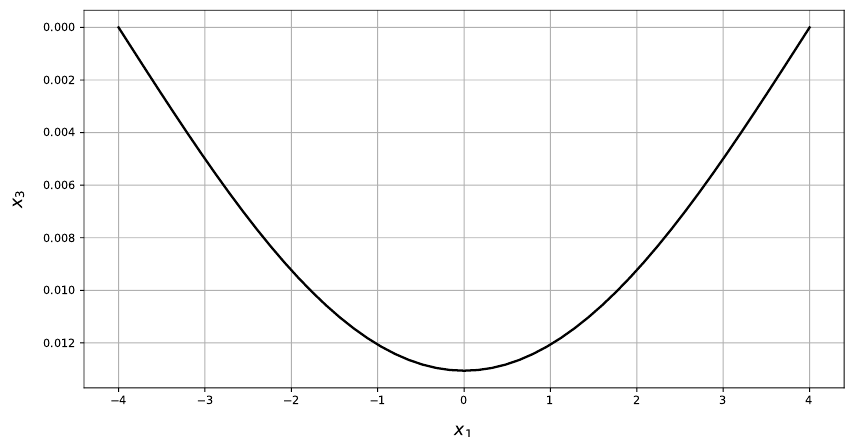
Figure 7. The deflection in section x 2 = 0 of a rectangular plate with two opposite edges simply supported and the other free.